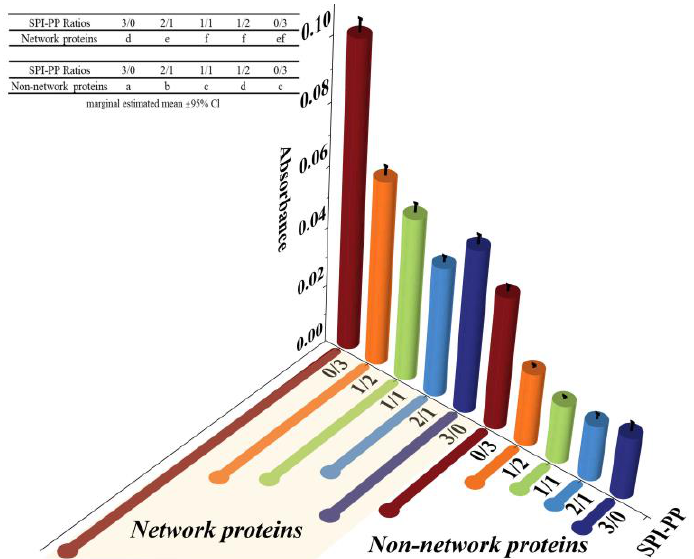
Figure 3. Turbidity analysis of network proteins and non-network proteins at different SPI and PP ratios.